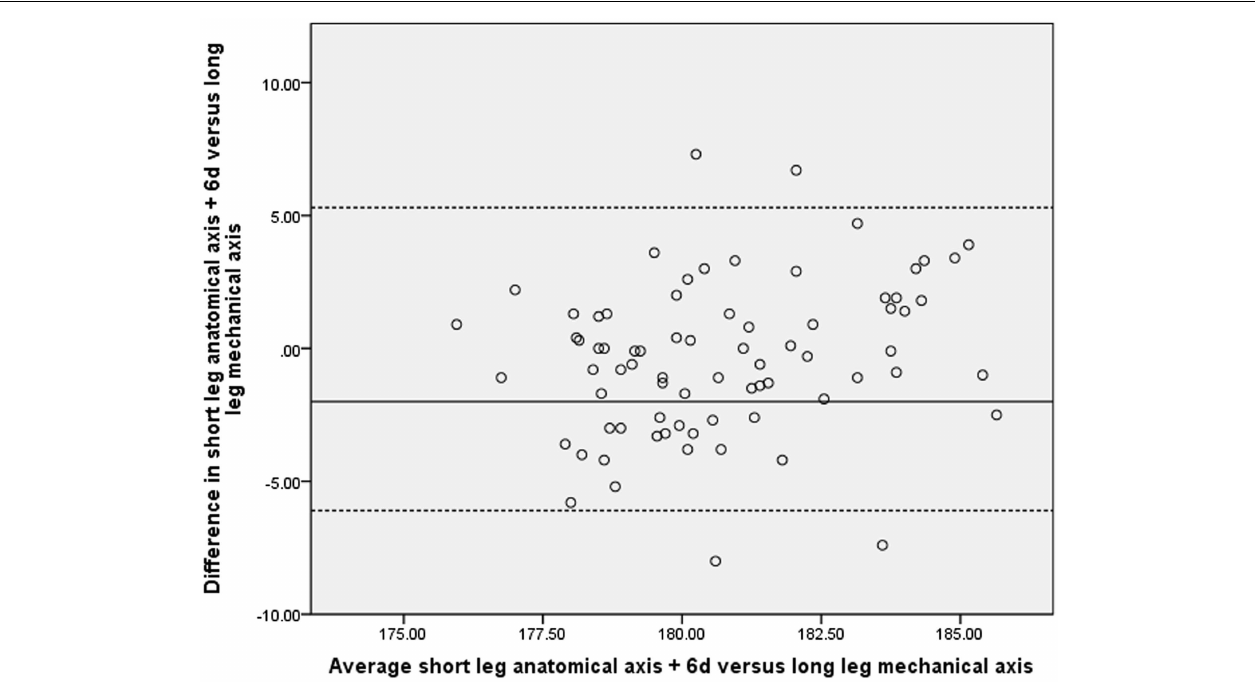
FIGURE 1 | Comparison of long and short-leg X-rays using Bland–Altman method